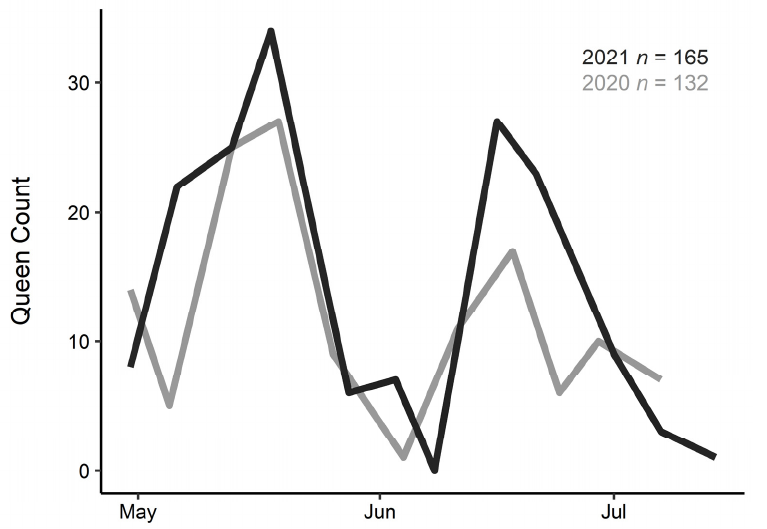
Figure 1. Bumble bee queens ( B. huntii ) emerged across two and a half months during the spring with a marked bimodal distribution across both 2020 (grey; n = 132) and 2021 (black; n = 165).